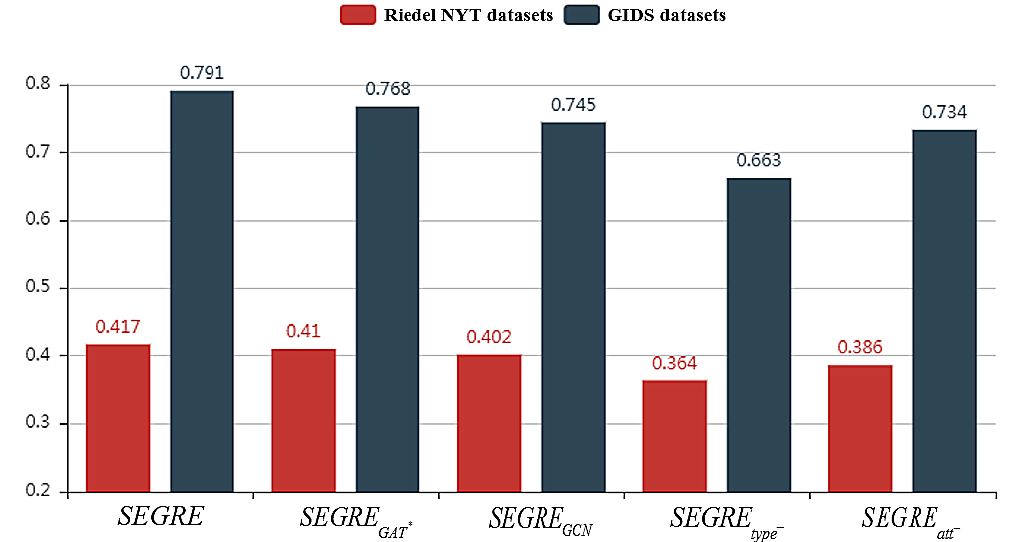
Figure 4. Performance comparison of different SEGRE ablated version on two